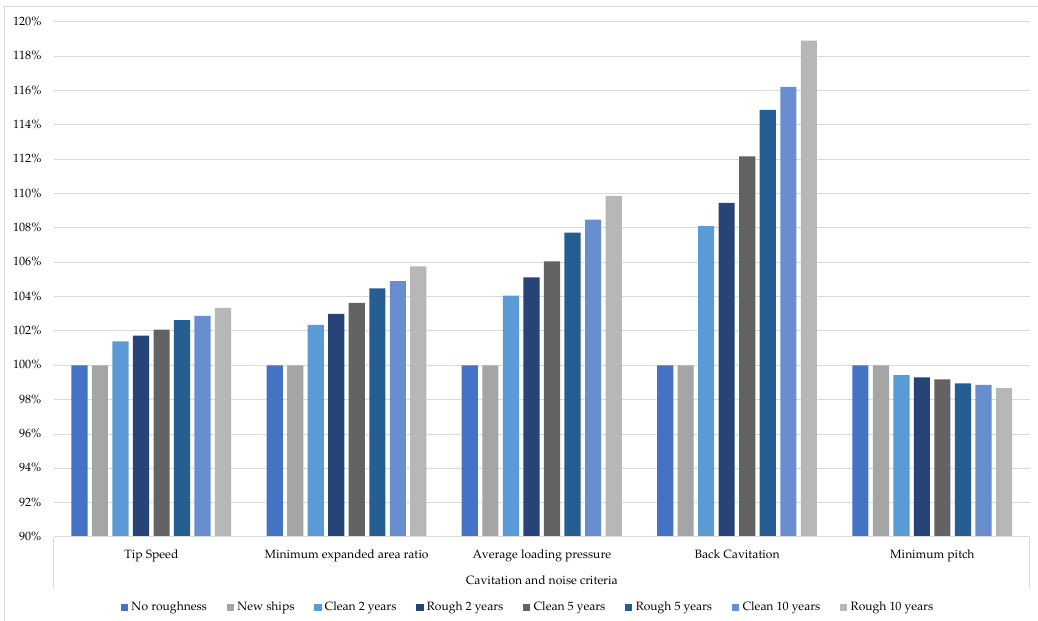
Figure 4. Percentage of change in engine characteristics for different hull roughness. Regarding the propeller characteristics, as presented in Figure 2, an increase in pro- peller speed along the simulated cases showed a maximum increment of 4% comparing the same ship in new conditions and rough conditions after 10 years. This increment in propeller speed was due to the increase in the thrust required to achieve the same ship speed (14.5 knots), which was increased by up to 10% comparing the first and the last cases. The propeller torque exhibited the same behavior, which increased with the in- crease in the level of roughness by up to 9% to provide the required thrust to the ship with a slight reduction in torque, while the advance coefficient was reduced when the propeller speed increased by around 3% comparing the same two cases. This increment in thrust and torque directly affects the propeller coefficient, leading to increases the thrust and torque coefficients by 3% and 2%, respectively. According to these changes in propeller coefficients, the open water efficiency followed the same